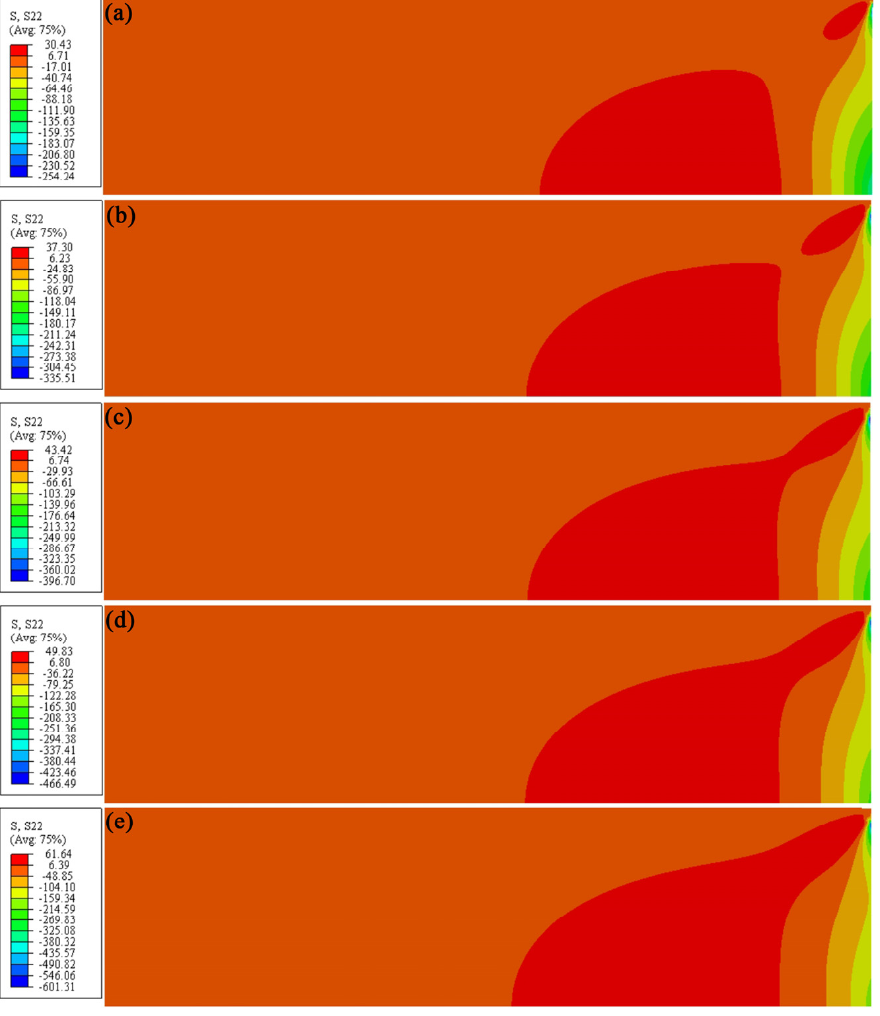
Figure 14. Effects of different Yb 2 SiO 5 contents in the interlayer on stress distributions: ( a ) All Yb 2 Si 2 O 7 ; ( b ) 0.3 mol Yb 2 SiO 5 & 0.7 mol Yb 2 Si 2 O 7 ; ( c ) 0.5 mol Yb 2 SiO 5 & 0.5 mol Yb 2 Si 2 O 7 ; ( d ) 0.7 mol Yb 2 SiO 5 & 0.3 mol Yb 2 Si 2 O 7 ; ( e ) All Yb 2 SiO 5